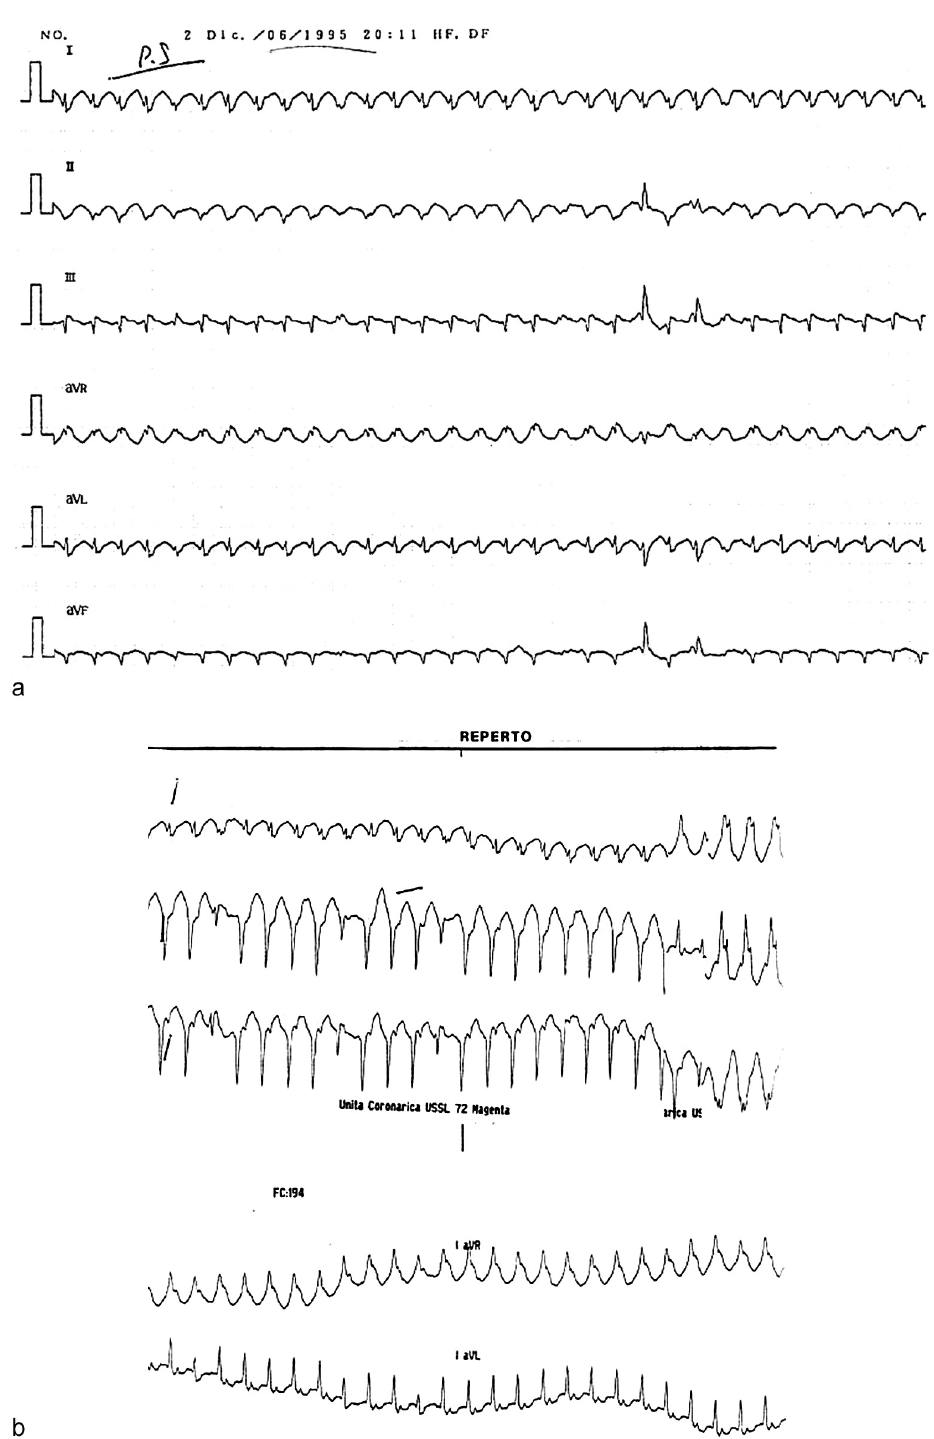
Figure 1 . Monomorphic sustained VT at 220 bpm, LBBB with superior axis